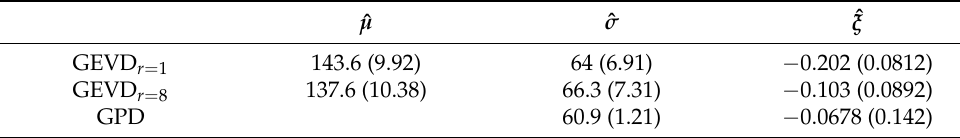
Table 3. Parameter estimates with standard errors in parentheses.